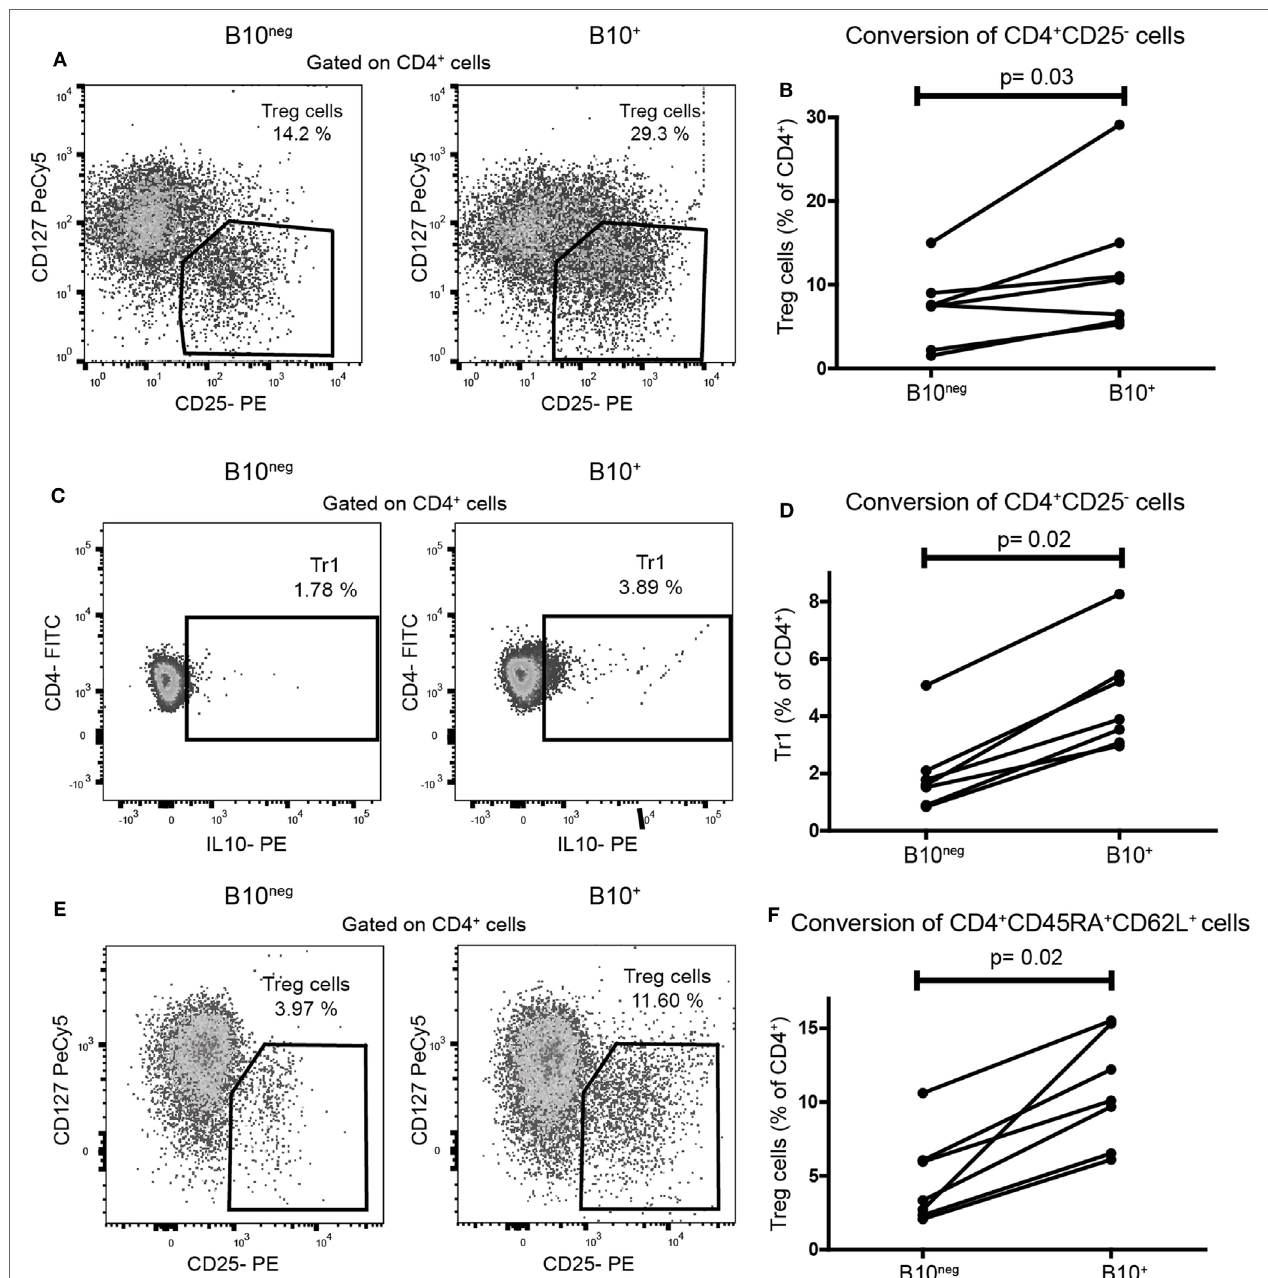
FigUre 2 | CpG induced B10 + cells from healthy subjects increased regulatory T (Treg) cells and Tr1 differentiation from naïve T cells. Sorted B10 + cells or B10 neg cells were co-cultured for 72 h with autologous CD4 + CD25 − cells or CD4 + CD45RA + CD62L + naïve T cells stimulated with anti CD3. Treg cells, defined as CD4 + CD25 hi CD127 lo/neg , and Tr1, defined by CD4 + IL-10 + , were assessed by flow cytometry. Representative flow cytometry plot (gated on CD4 + cells) and percentages of CD4 + CD25 − cells conversion by B10 + or B10 neg into Treg cells (a,B) or Tr1 (c,D) cells are presented. (e,F) Flow cytometry plot and graph presenting the conversion of CD4 + CD45RA + CD62L + by B10 + cells or B10 neg cells. Each connected pair of dots represents individual donor and results were obtained from independent experiments done in seven patients. p Values were calculated with Wilcoxon matched pairs